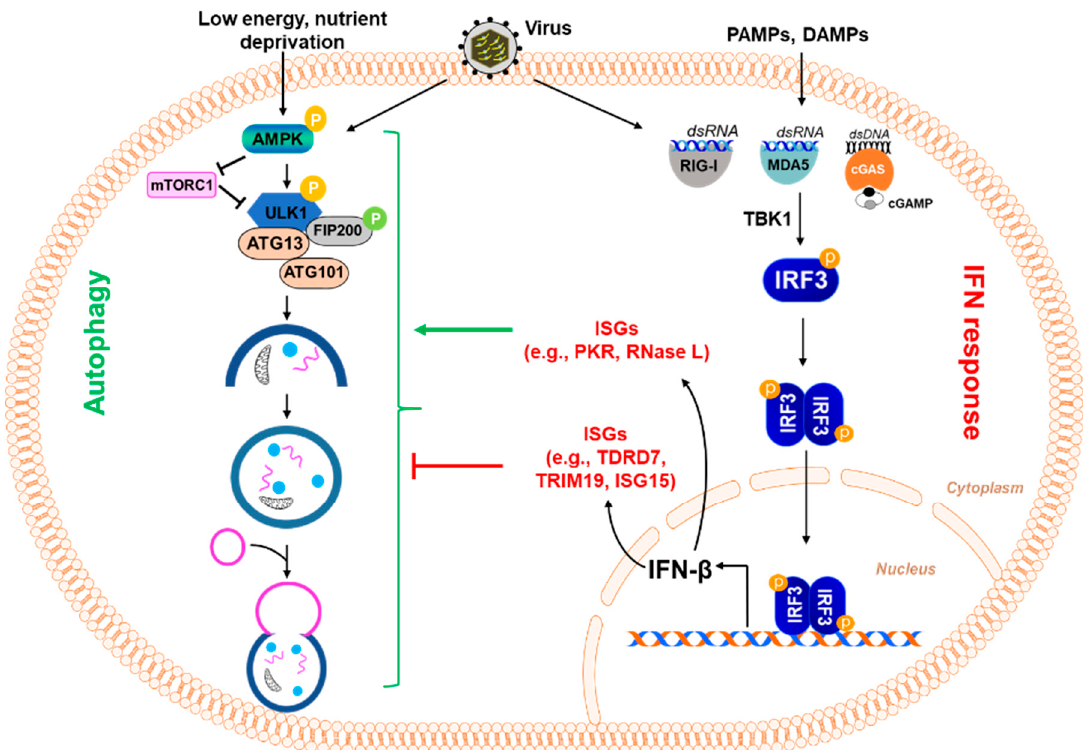
Figure 3. Regulation of the autophagy pathway by interferon-stimulated genes. Virus infection and exposure to PAMPs and DAMPs result in the activation of IRF3, which causes the induction of type-I interferon (e.g., IFN β ) and other IFN-stimulated genes (ISGs) (e.g., TDRD7, TRIM19, ISG15, etc.). These ISGs can inhibit viral replication in different ways, including their ability to inhibit autophagy, which some viruses induce for their own benefit. In this figure, some ISGs are shown because of their ability to inhibit autophagy. TDRD7 inhibits autophagy by blocking the activation of AMPK, the kinase that initiates the autophagy pathway. TRIM19 acts by suppressing virus-induced LC3-I to LC3-II conversion, which is essential for autophagy. Another ISG, ISG15, ISGylates BECN1, critical for autophagy, resulting in its loss of activity and thus inhibiting the induction of autophagy. In contrast, other ISGs, e.g., PKR, RNase L, can activate the autophagy pathway. Viperin, the virus-inhibitory protein, which is endoplasmic reticulum-associated and interferon-inducible, inhibits the replication of many viruses, such as flaviviruses. The Another family of immune modulators, known as tripartite motif (TRIM) proteins, amphipathic nature of viperin allows it to interact with the ER and lipids, diversifying its often induced by IFN, are ubiquitin E3 ligases that carry out diverse anti-viral functions by anti-viral effects [48]. Keeping this in mind, HCV replicates its RNA on lipid droplets by either directly inhibiting a viral life cycle or by helping to induce the anti-viral autophagy interacting with NS5A, a similar viral amphipathic protein. Further along the autophagy of virus-infected cells. For instance, TRIM5 α interacts with the HIV-1 capsid protein to pathway against HCV, viral NS5A is bound by SCOTIN/SHIAS5, another host ISG induce the disassembly of HIV-1 progeny. TRIM proteins play various roles in autophagy localized in the ER, leading to its autophagosomal degradation and the inhibition of HCV induction by upregulating IFN transcription and regulating pattern-recognition receptors RNA replication [37]. Both points are proposed mechanistic targets of the anti-HCV action with anti-viral signaling cascades. HSV-1, SINV, and adenovirus activate TRIM23’s E3 enzymatic activity, to ubiquitinate cellular proteins linked to viral cargo for their eventual degradation within autophagosomes. TRIM23 is unique in that it also serves as a GTPase to regulate TBK1’s phosphorylation of p62, to enhance cargo recognition in autophagy